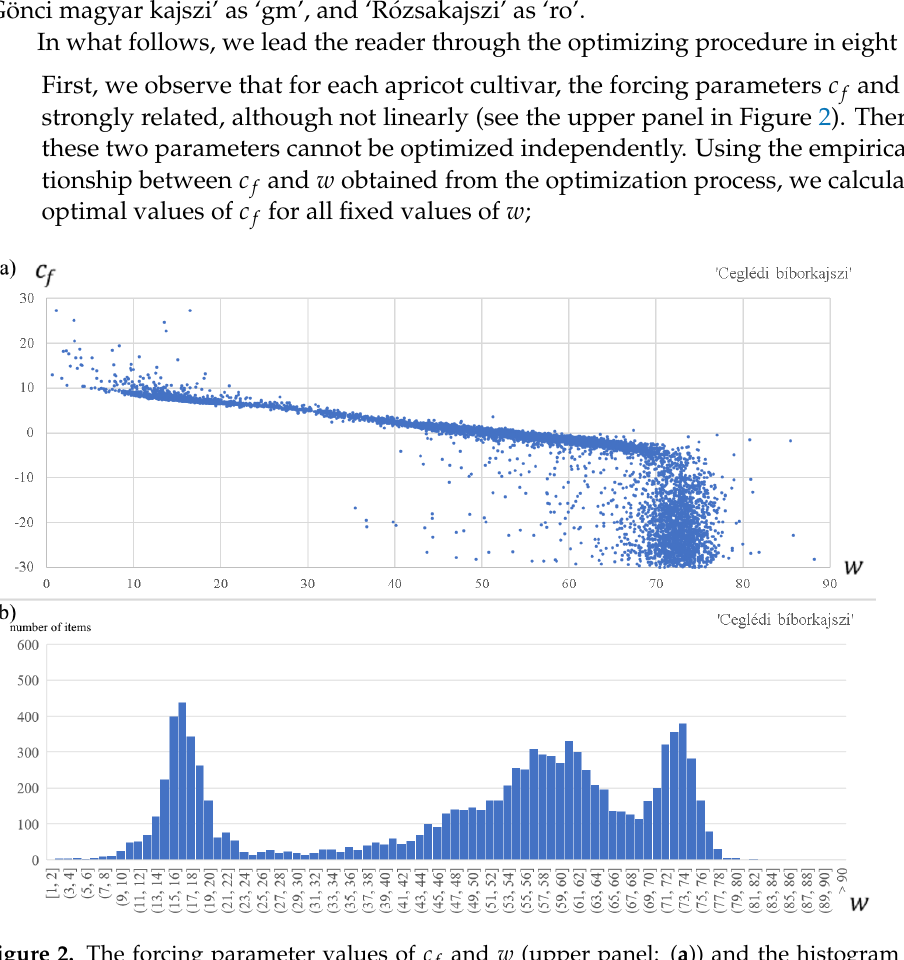
Figure 2. The forcing parameter values of c f and w (upper panel: ( a )) and the histogram of the optimal forcing parameter values of w (lower panel: ( b )) for ‘Cegl é di b í borkajszi’, based on 10,000 ran- dom walk optimization processes. (We obtained similar diagrams for ‘Gönci magyar kajszi’ and ‘R ó zsakajszi